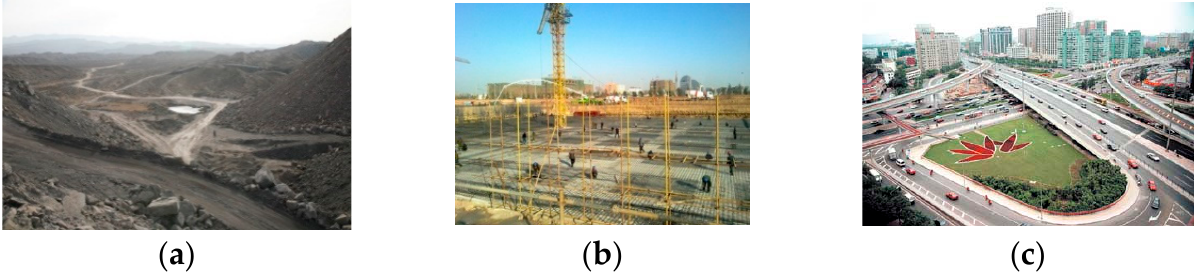
Figure 10. Spatial forms of construction land: ( a ) mining area; ( b ) building area; ( c ) construction land